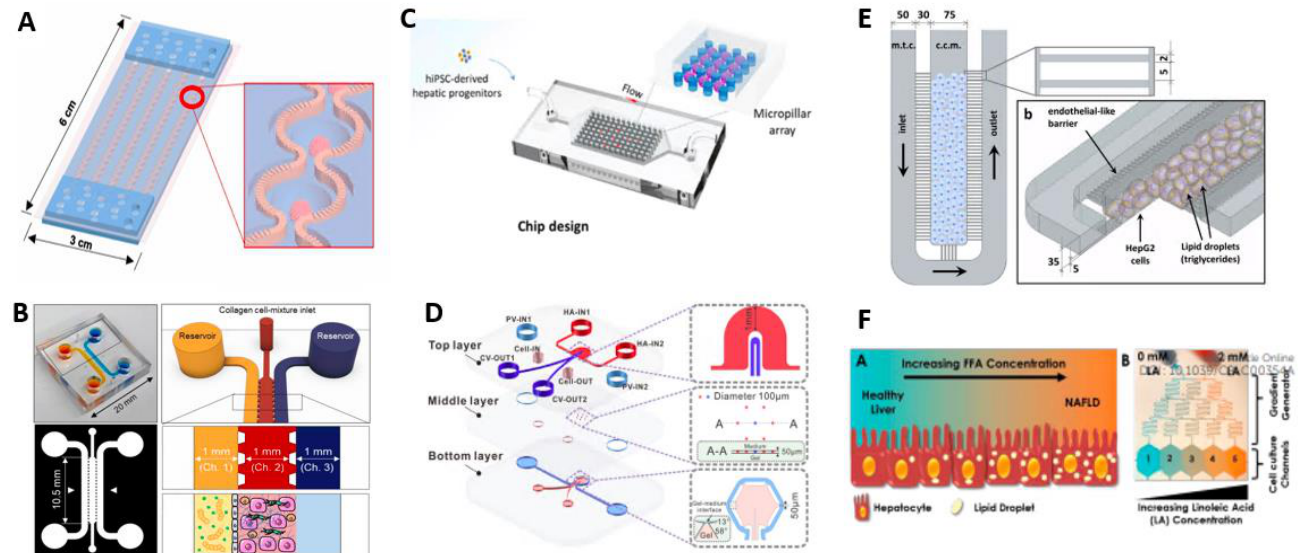
Figure 2. Modeling NAFLD using microfluidic devices. ( A ) Steatochip recapitulating liver micro- structure, for growth and differentiation of HepRG cells [54] (reproduced with permission from Teng et al., 2021). ( B ) NASH-on-chip, prepared with hydrogel channel with hepatic, Kupffer and stellate cells [55] (reproduced with permission from Freag et al., 2020). ( C ) NAFLD-on-chip inducing differentiation of hiPSC to organoids followed by steatosis progression [56] (reproduced with per-